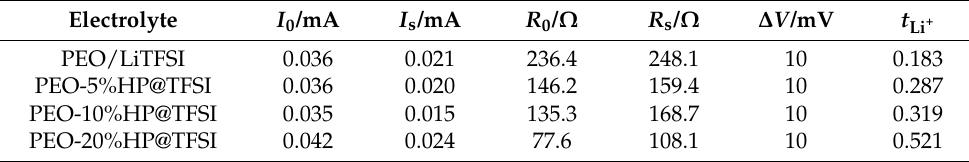
Table 2. Li + ion transference number data of polymer